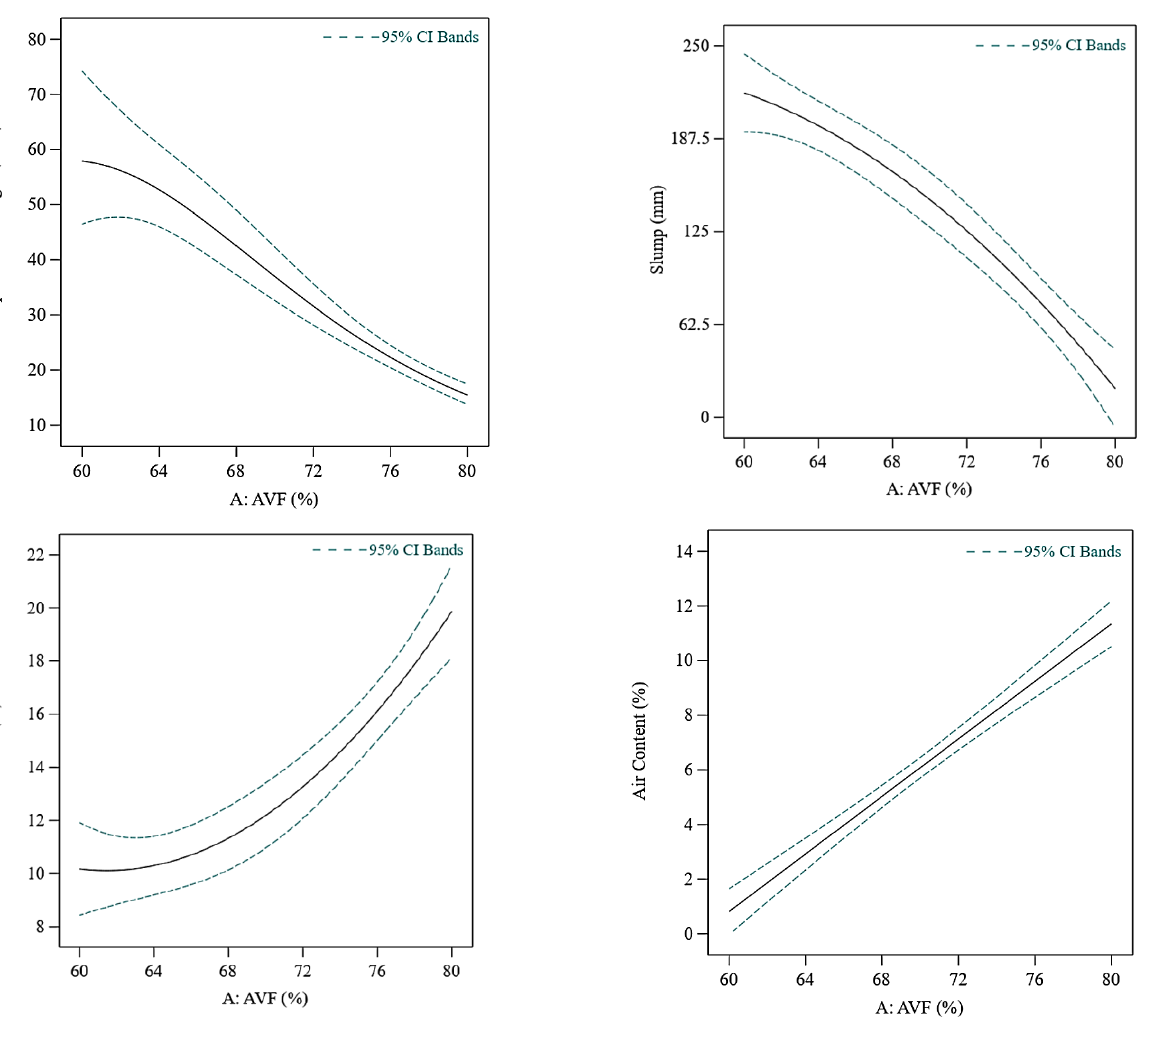
cles. Figure 4. Cross-sections of GC2, GC5, GC13, GC1, and GC9 mixes representing an AVF of 60%, 65%, 70%, 75%, and 80%, respectively. AVFs also affected the AVPP: the AVPP was increasing in an increasing trend as the AVFs increased. The lowest AVPP of about 10% was obtained at an AVF of 60%, while the value increased to about 19% at the highest AVF of 80%. A similar trend was observed